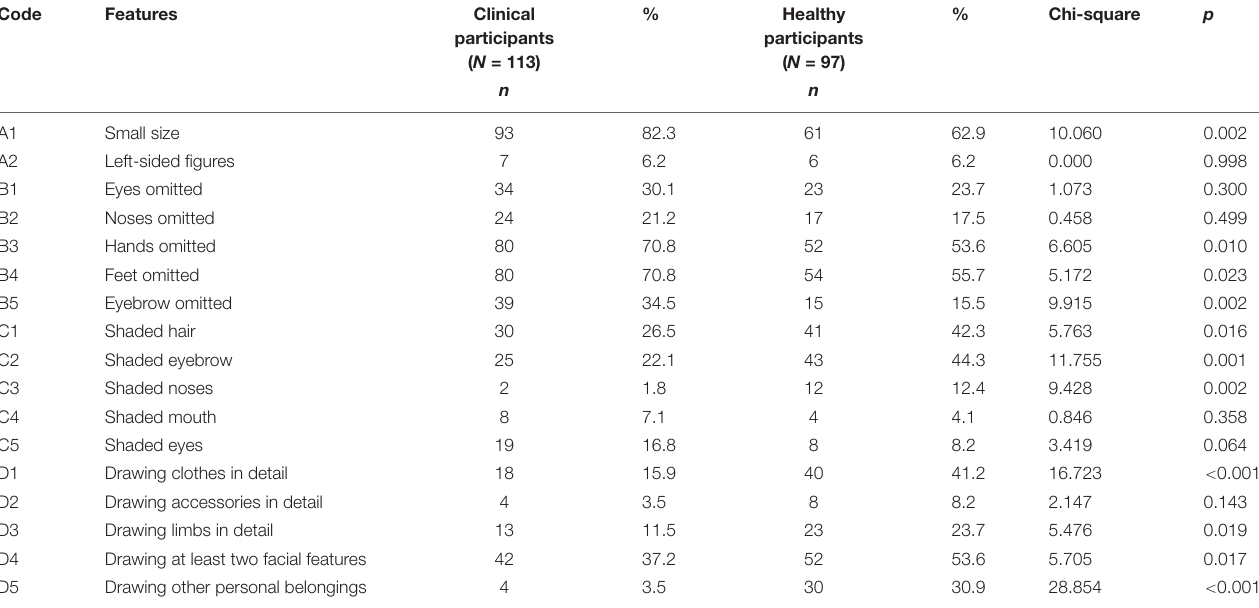
FIGURE 3 | ROC curve of drawing features negatively associated with depression. TABLE 3 | Chi-square test results for drawing feature